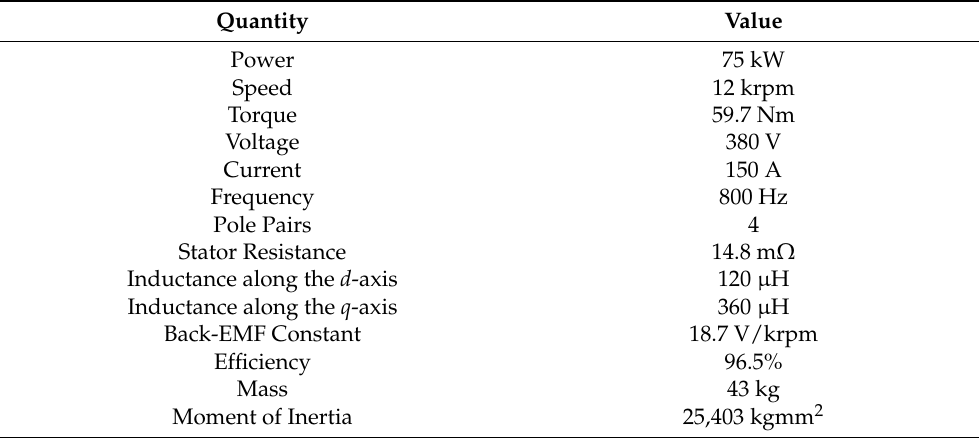
Table 2. Nominal characteristics of the SRPM205M8XO75 electric